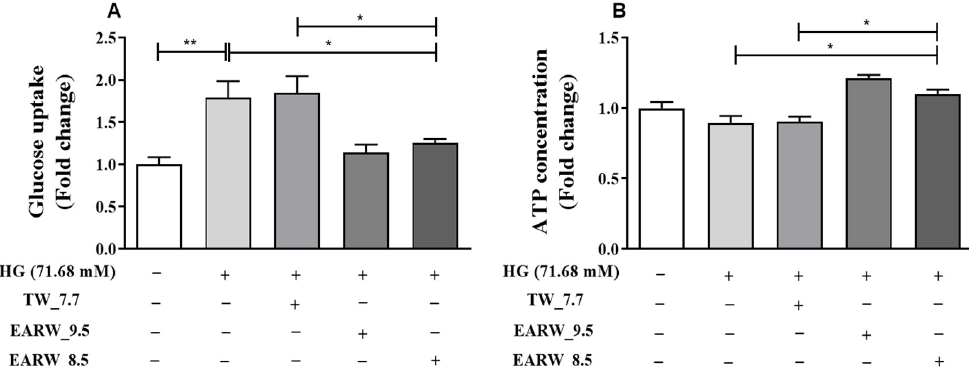
Figure 4. Effects of HG-induction on glucose uptake levels and ATP concentrations in HK-2 cells treated with TW_7.7, EARW_9.5, or EARW_8.5. HK-2 cells were induced with HG (71.68 mM) and